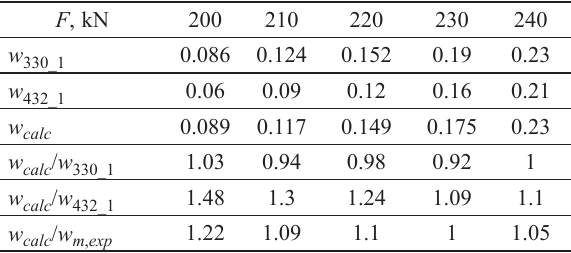
Table 4. Summary of crack width results